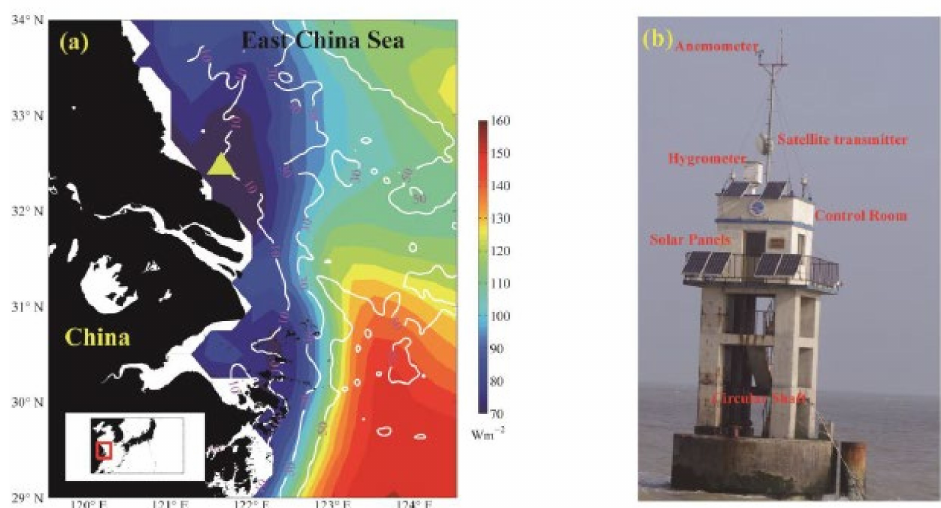
Figure 1. ( a ): The topography (white contours) of the East China Sea (ECS) with data from the General Bathymetric Chart of the Oceans (GEBCO, http://www.gebco.net accessed on 15 December 2021). The yellow triangle represents the location of the Huo Xing Sha platform. The coloured background is the annual mean Q LH in 2016 and 2017 based on the ECMWF ERA-5 reanalysis. The incorporated frame (red) represents the study area of the ECS. ( b ): The in situ architecture of the platform with the structure labelled with red